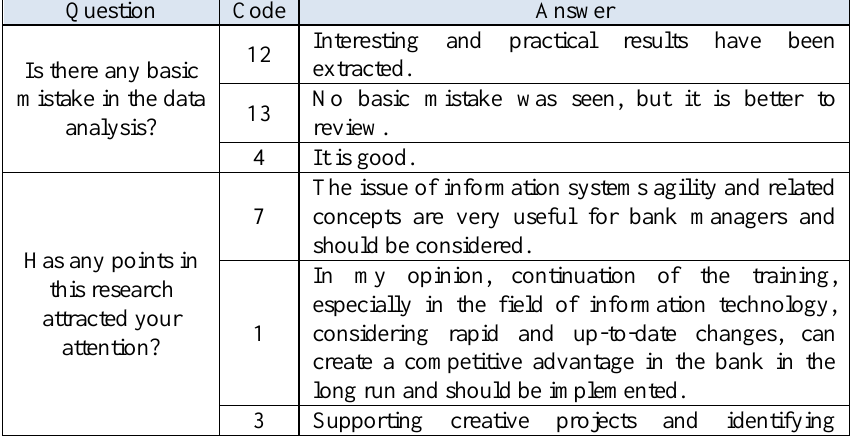
Table 2. Qualitative validity corresponding to the validation by the